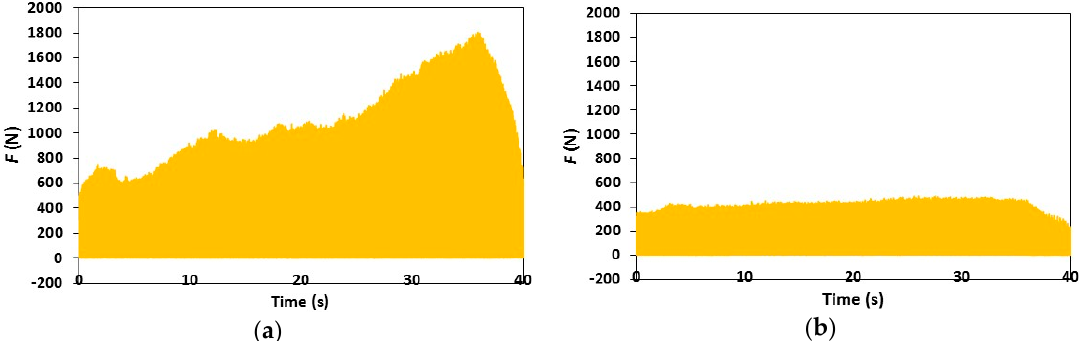
Figure 10. F curves (recorded data) of Tool wet2 milling experiment during ( a ) the second pass, and ( b ) the third pass.